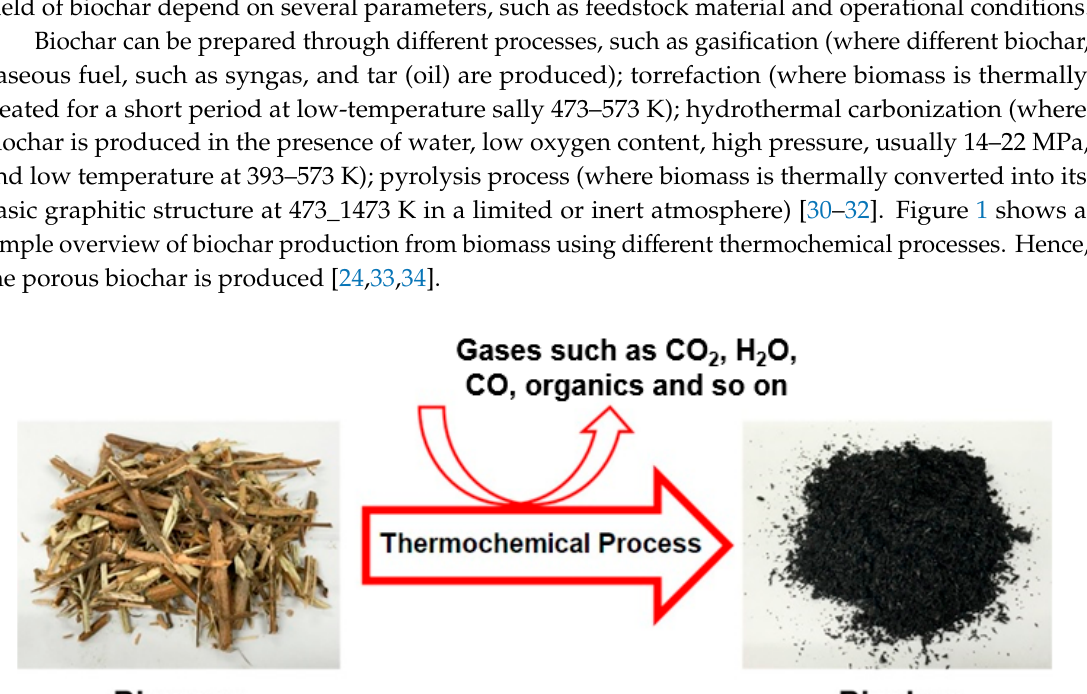
Figure 1. A general overview of biochar production from different biomasses.